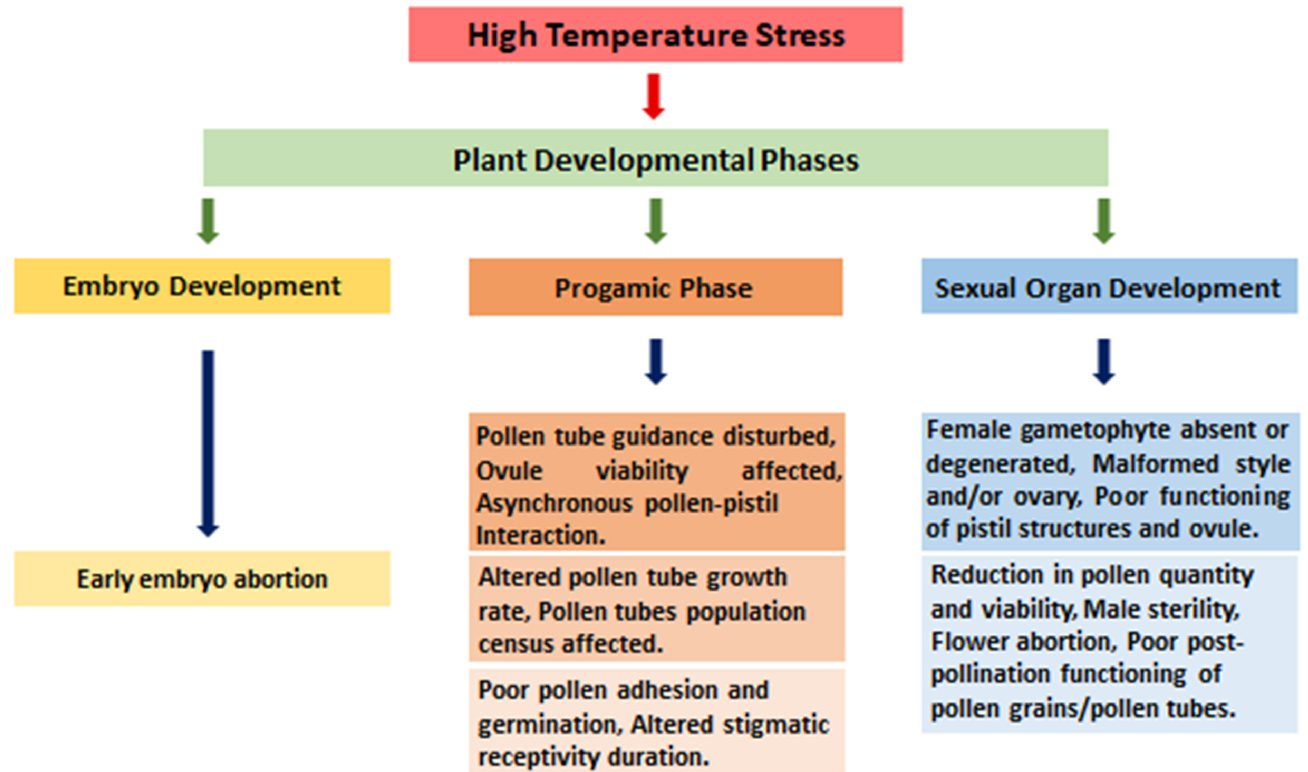
Figure 2. Effects of high temperature stress on reproductive phases of plant